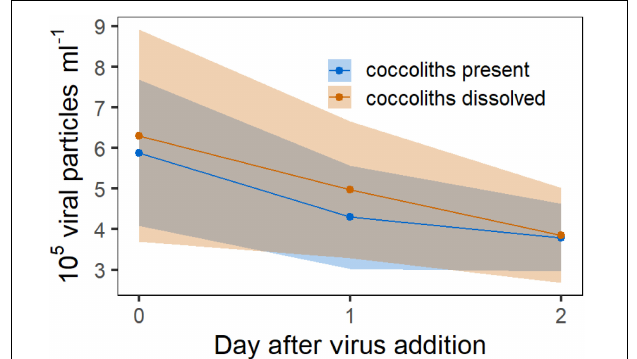
FIGURE 8 | Experiment 6. Counts of viral particles in a 5 µ m filtered culture of E. huxleyi which contained no algal cells but detached coccoliths. Red symbols represent mean concentration of viral particles in the solution in which the coccoliths were dissolved with acid and base. Ribbons represent the 95%